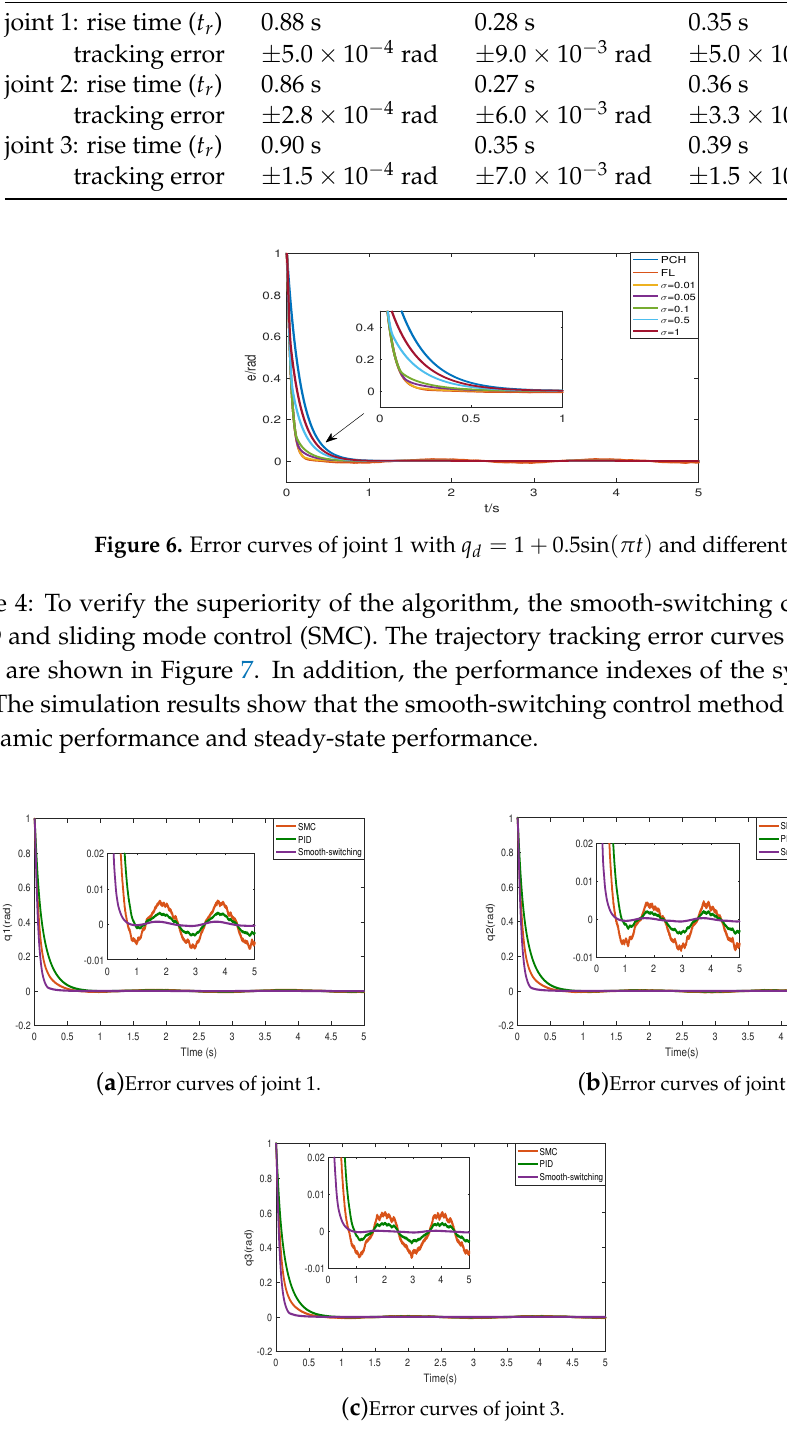
Figure 7. Error curves of three joints-based PID, SMC and smooth-switching with q d = 1 + 0.5sin ( π t ) and σ =